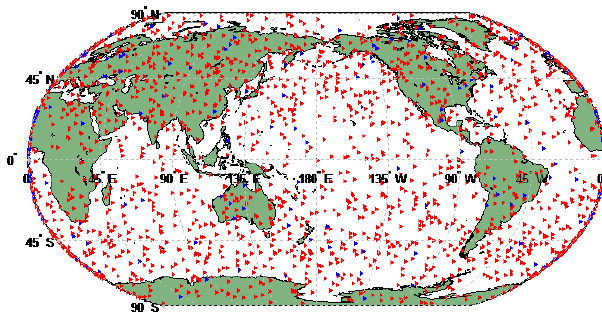
Figure 3. The global distribution of COSMIC RO events on 12 De- cember 2013. Blue triangle represents the selected 200 RO events. Table 4. Summary of the comparison between ROPP-derived and atmPrf. ND-phs represents the comparison between ND-derived and atmPhs-derived; ND-prf represents the comparison between ND-derived and atmPrf; phs-prf represents the comparison between atmPhs-derived and atmPrf